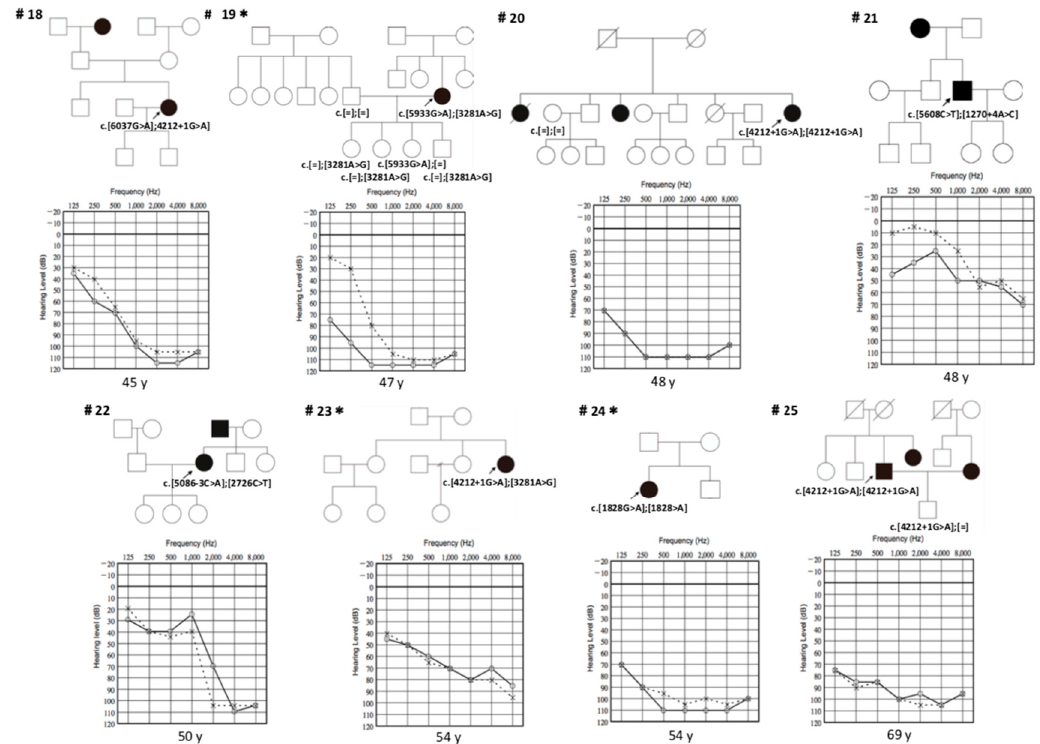
Figure 1. Pedigree and audiograms for each family with LOXHD1 variants. Arrows show the probands in each family (family numbers 1–25). Genetic findings for each individual tested are noted in the pedigree. The age at the time of their genetic and audiometric testing is noted below the audiogram. ＊ These families include the variations mentioned in the footnote of Table 1.